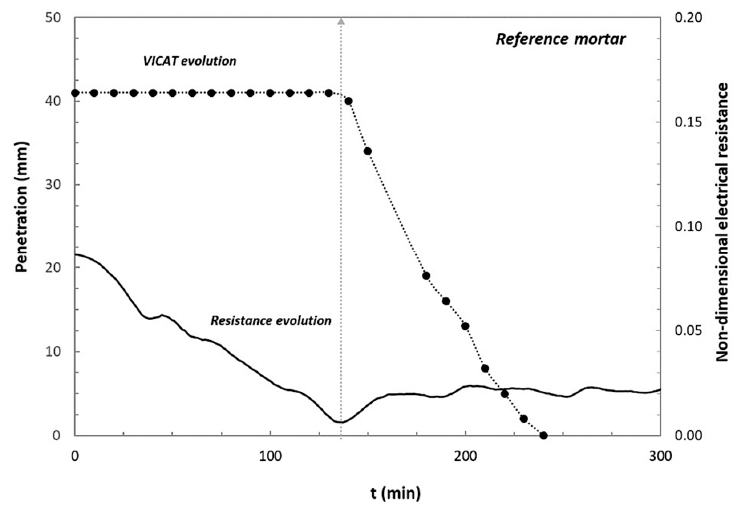
Figure 5. Comparison between needle penetration during VICAT test and electrical resistance evolution for the reference mortar.